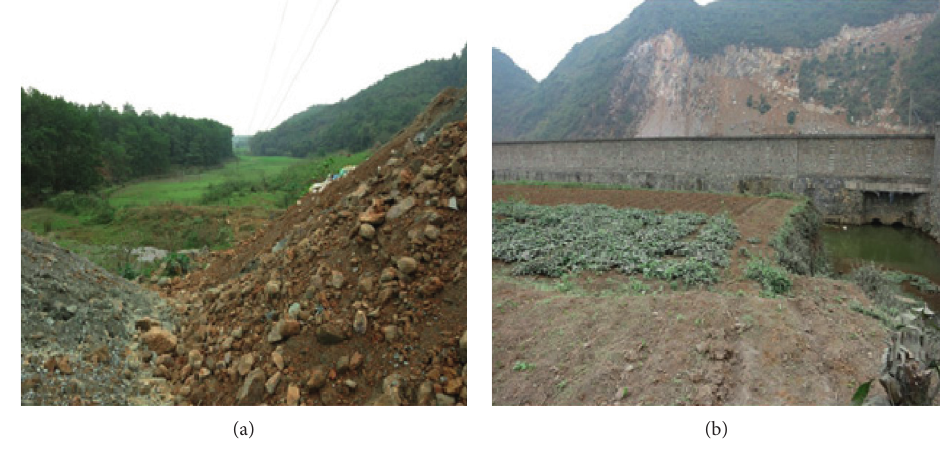
Figure 3: Sampling point in residential, ecological area.